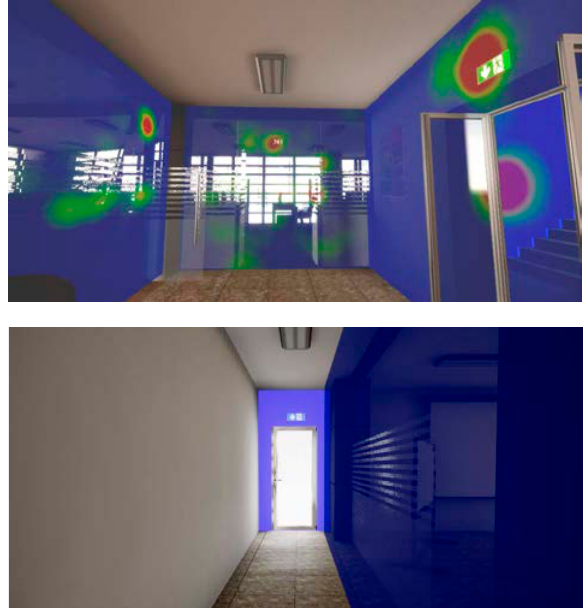
Figure 8-9: Eye-tracking data in one